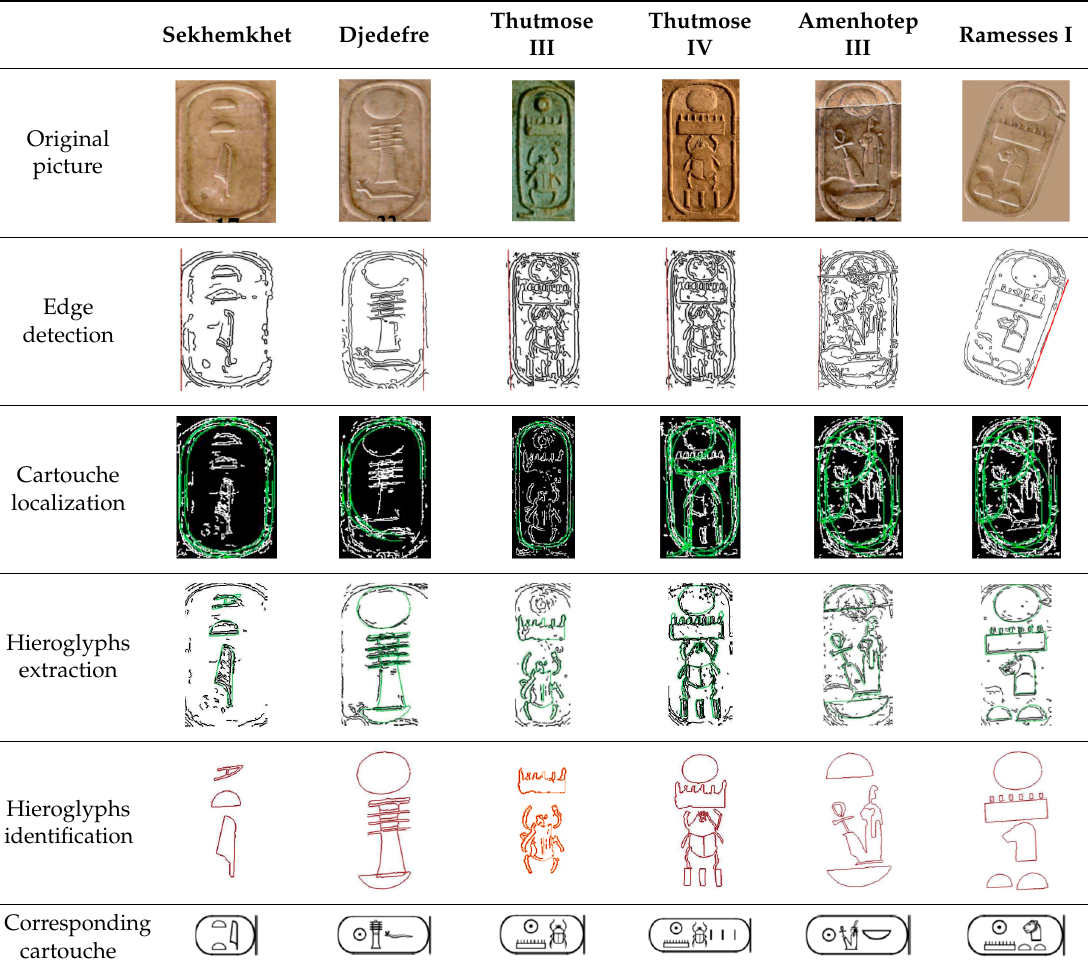
Table 3. Intermediate and final visual results of six images.